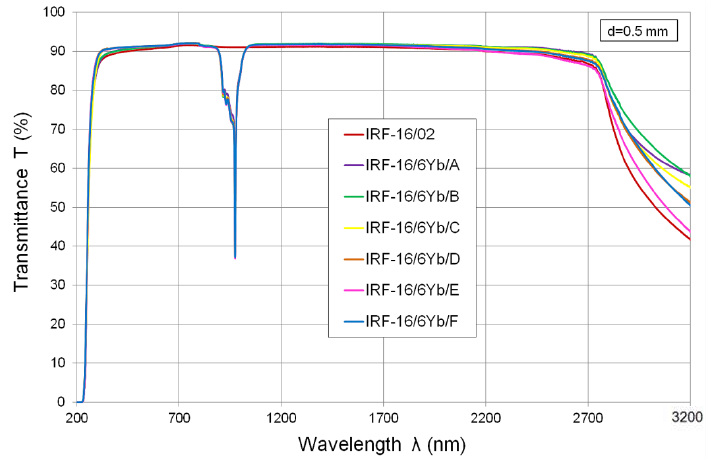
Figure 2. Spectral absorption characteristics of host matrix IRF-16/02 glass and active rod IRF-16/6Yb/F glass (small 100-g batch meltings).